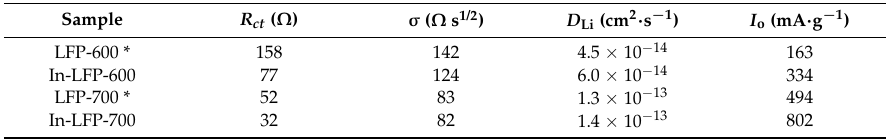
Table 4. Charge transfer resistance, Lithium diffusion coefficient, and exchange current density LFP-600 and LFP-700 compared with In-LFP-600 and In-LFP-700 samples.